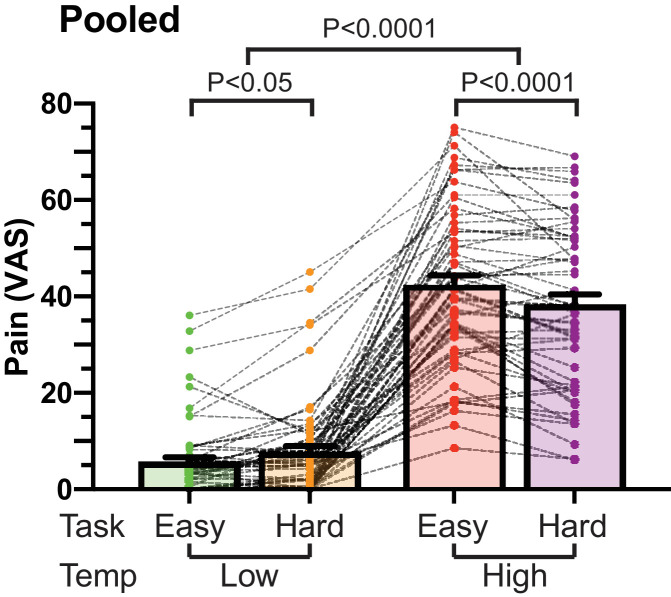
Pain ratings across experimental conditions for the pooled cohort (N = 57). A 2-way repeated measures ANOVA on the pain ratings showed the expected main effect of temperature (P < 0.0001) and a task x temperature interaction (P < 0.0001). The attentional analgesic effect was observed as a decrease in pain scores in the high temperature condition during the hard task compared to the easy task (P < 0.0001, post-hoc paired t-test). In contrast there was also a small increase in pain scores in the low temperature condition during the hard task compared to the easy task (P < 0.05). The main effect of task was not significant (P = 0.92). Error bars represent the standard error of the mean.